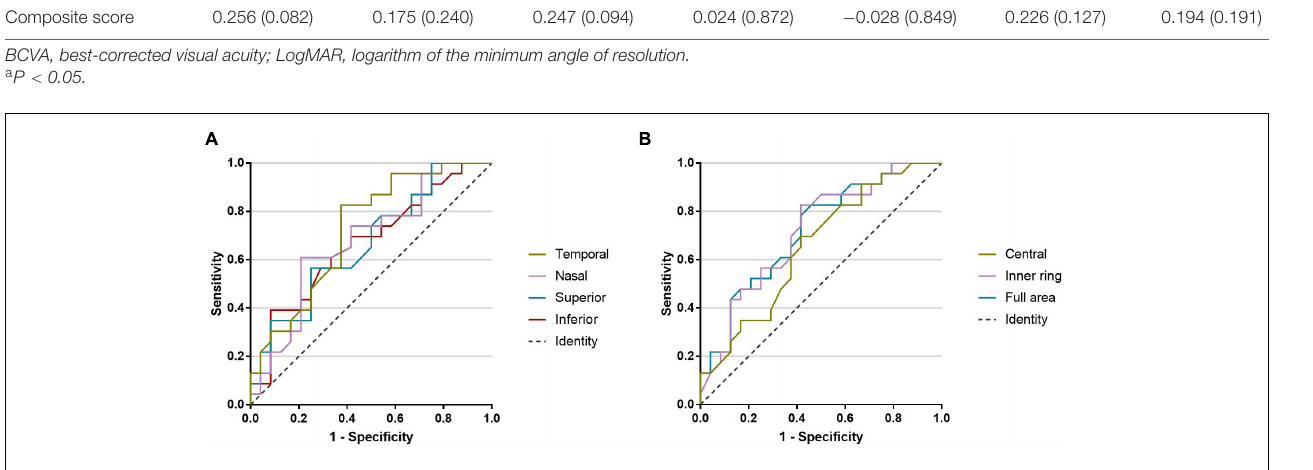
FIGURE 4 | The AUROCs for discriminating PD patients from healthy controls. (A) Macular microvascular density of the 3-mm-diameter region: temporal sector (0.723), nasal sector (0.678), superior sector (0.668), and inferior sector (0.668). (B) Macular microvascular density of the 3-mm-diameter region: central sector (0.655), inner ring (0.716), and full area